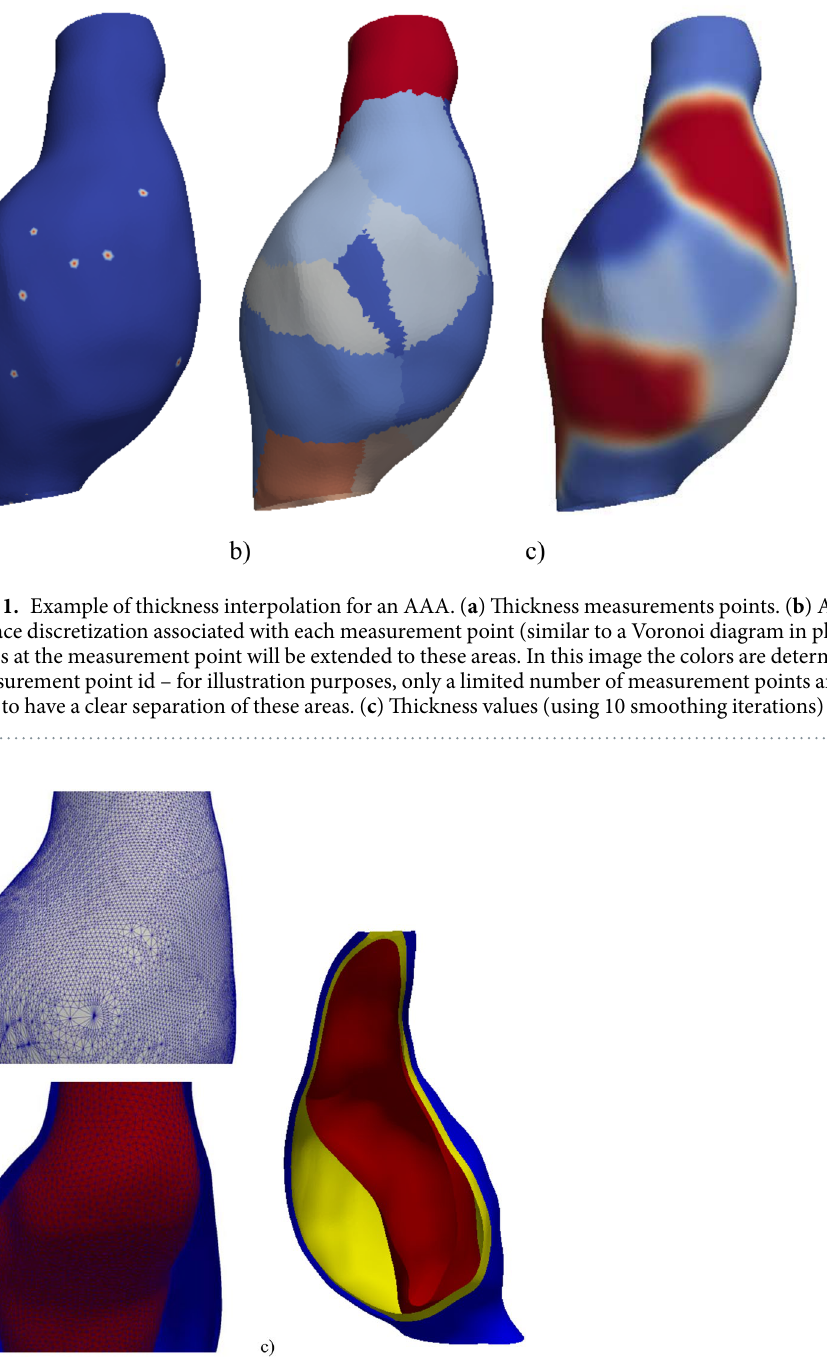
systems. Registration involves aligning different images into the same coordinate system. Automatic regis- tration of inter-modality images is practically impossible most of the time, because different image modali-